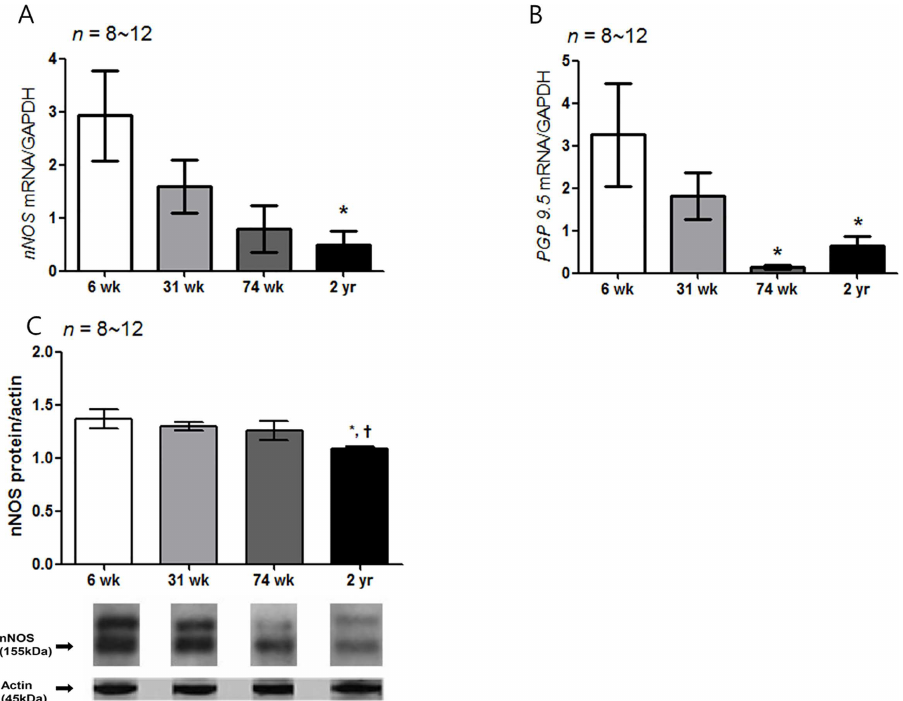
Fig 8. Expression of nNOS and PGP 9 . 5 mRNA and nNOS protein. (A) The expressionof nNOS mRNA measured by real-timePCR decreasedwith age. The nNOS mRNA expression decreasedin the 2-yr-oldrats compared with the 6- wk-oldrats ( P = 0.021):6-wk-oldrat group( n = 10), 31-wk-oldrat group( n = 10), 74-wk-old rat group( n = 8) and2-yr-oldrat group( n = 12). (B) The PGP 9 . 5 mRNA expressionof the 74-wk-oldand2-yr- old rats was alsolower than that of the 6-wk-oldrats ( P = 0.007, 6-wk- vs . 74-wk-old rats and P = 0.030,6-wk- vs .2-yr-oldrats), respectively. (C) The nNOS proteinexpression was the lowestin 2-yr-oldrats. That is, the nNOS proteinexpression of the 2-yr-oldrats was significantly lowerthan that of the 6-wk-oldrats ( P = 0.007) ( n = 8–12in 6-, 31-, 74-wk-and2-yr-oldrats). The results are shownas the meanvalueof the opticaldensity (OD). Each bar representsthe mean ± SE. * P < 0.05 compared with6-wk-oldrats; † P < 0.05 compared with 31-wk-oldrats; ‡ P < 0.05 comparedwith 74-wk-old